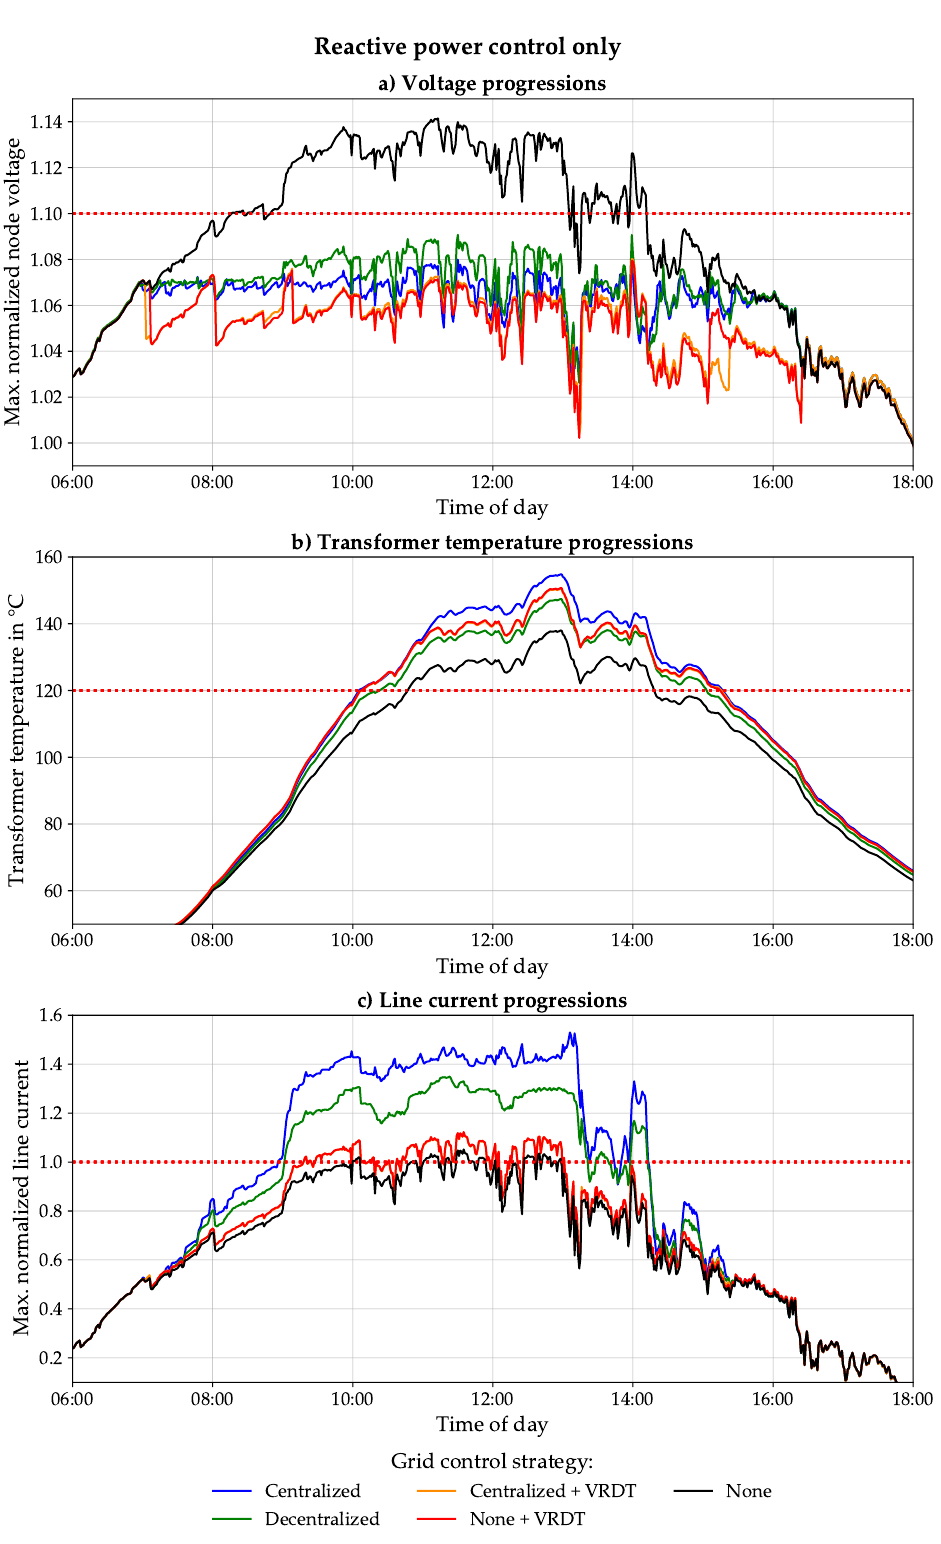
Figure 6. Performance comparison of the centralized and decentralized grid control strategies. Here, only reactive power control is used. Grid status progressions without flexibility-based grid control are given as a reference. The simulated day is 1 July. For comparability, all displayed progressions are based on the same random seeds. Maximum admissible values are indicated by red, dotted lines. ( a ) shows the progressions of the maximum node voltage in the grid. ( b ) shows the progressions of the transformer temperature. ( c ) shows the progressions of the maximum line current in the